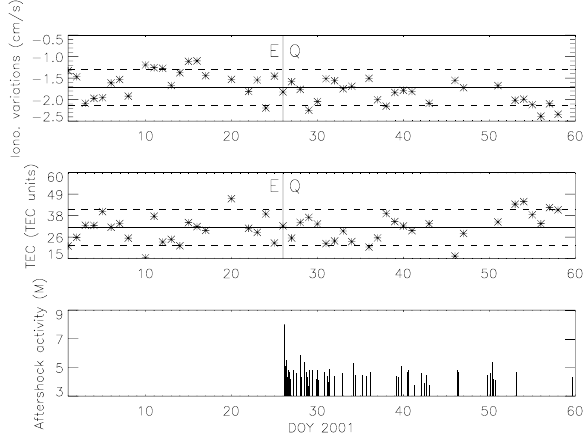
Fig. 4. Top panel: TEC variations in time as a function of the lat- itude for the two satellites SPOT2 and SPOT4 during two months around the time of the Bhuj earthquake. It concerns the data from the KITB station (see Fig. 2). Middle panel: Corresponding TEC values in TEC units (10 16 m − 2 ) . Bottom panel: Magnitude and occurrence of the main aftershocks. In the two first panels the hori- zontal full line represents the mean value, whereas the dashed lines indicate the variance, and the vertical line indicates the time of the Bhuj